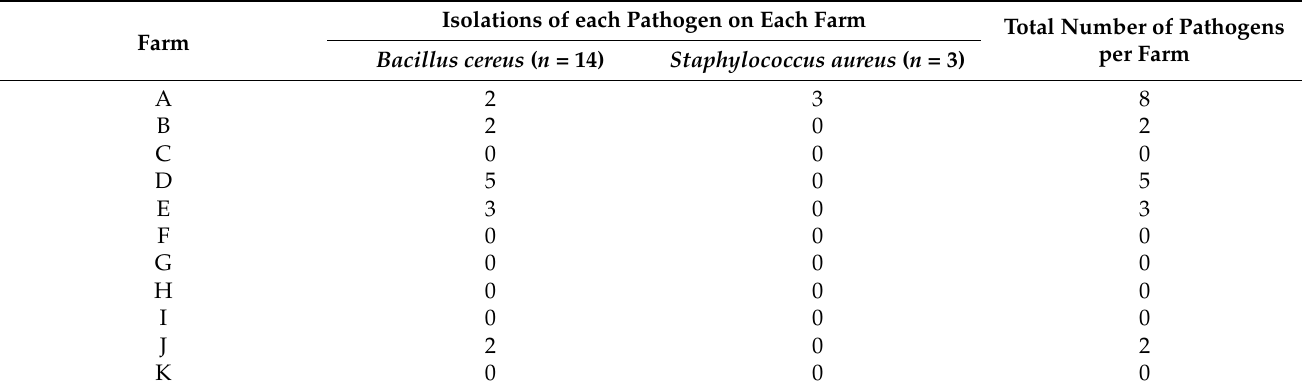
Table 11. Prevalence of B. cereus and S. aureus on each dairy farm (A to K).